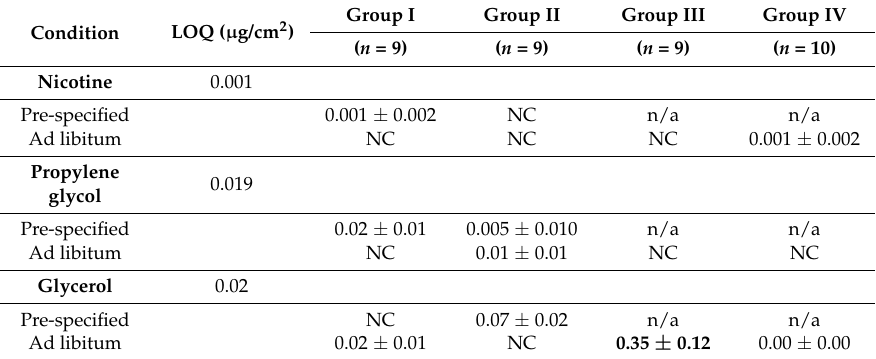
Table 2. Mean changes in the level of nicotine, PG and glycerol in surface samples from baseline to product use conditions ( µ g/cm 2